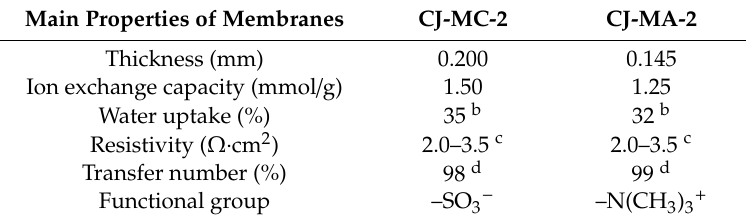
Table 1. The main properties of the membranes used in the experiments a